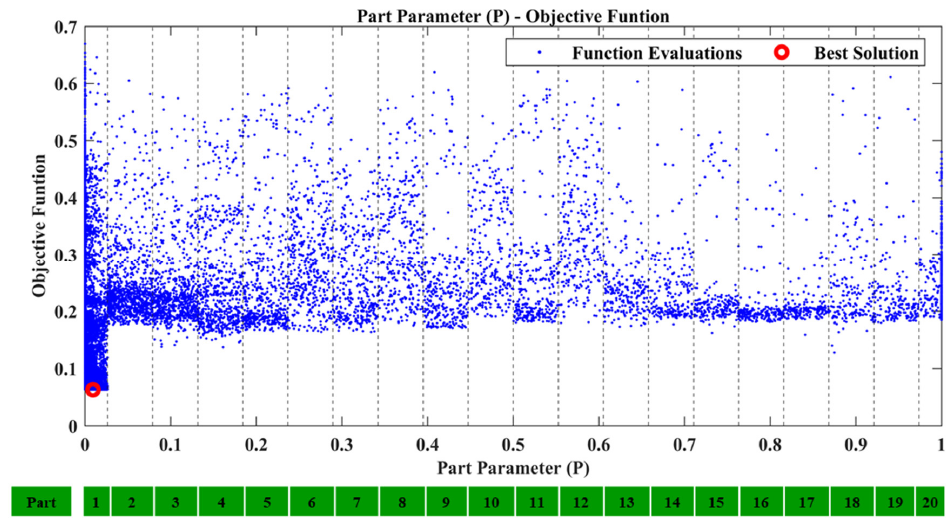
Figure 14. Case 2: Part parameter (P) versus the Objective Function values.